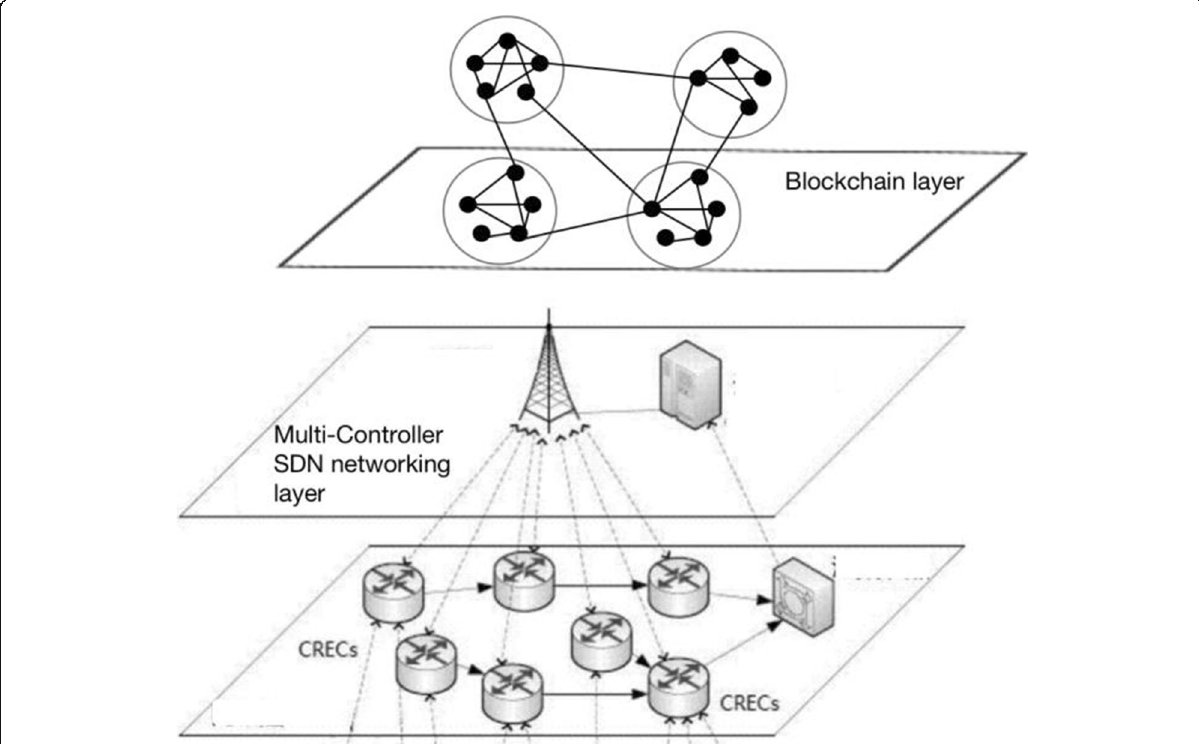
Fig. 6 Hybrid cloud service architecture based on blockchain and SDN [71]